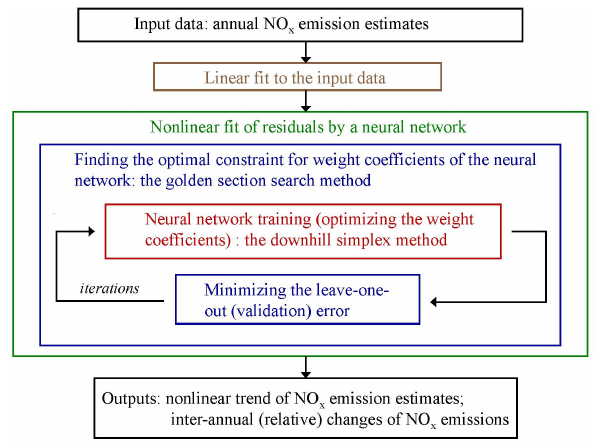
Fig. 5. Flow chart illustrating major steps of the algorithm for esti- mation of a nonlinear trend in a NO x emission time series.